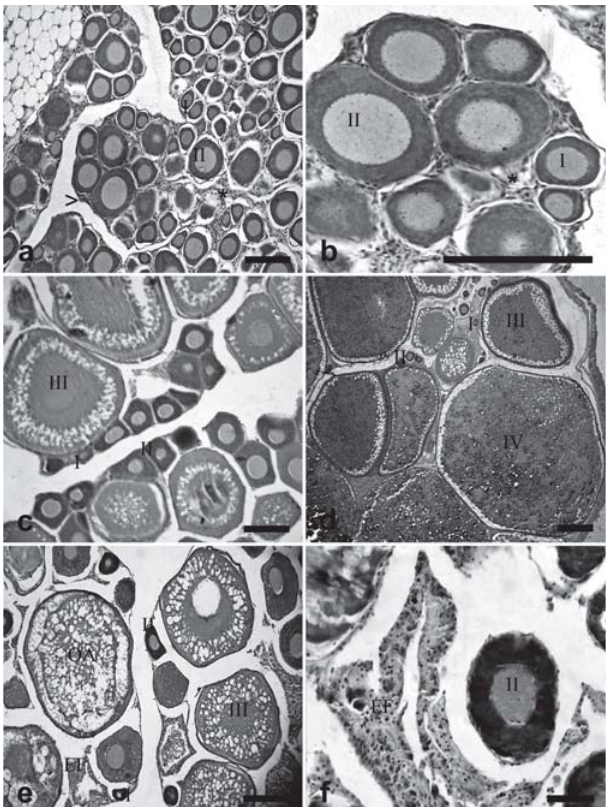
Fig. 1. Histological sections showing five gonadal matura- tion stages of Gymnotus aff. carapo ovary. a) Immature (10X); b) Immature ovaries in detail (15 X); c) Maturing (10X); d) Mature (4X); e) Spawning (10X); f) Spent (10X). Arrowhead - Tunica albuginea; Asterisk - connective tissue. Stages of oocyte development: I, II - reserve oocytes; III - Yolk vesicle oocytes; IV - Mature oocytes; OA: Oocytes-in-absorption; EF: Empty follicle. Scale bar = 500 µ